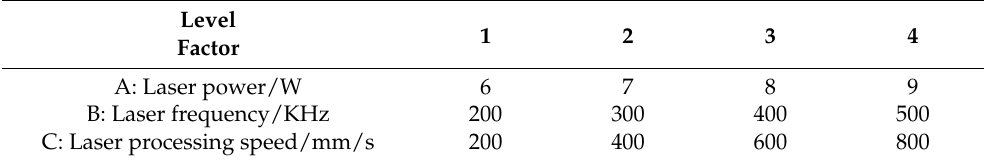
Figure 13. Experiment results of MCR frequency modulation with different parameters under the 50 × electron microscope: ( a ) 5 W, 200 KHz, 800 mm/s; ( b ) 8 W, 400 KHz, 400 mm/s; ( c ) 10 W, 500 KHz, 200 mm/s. Table 7. Factor level table.